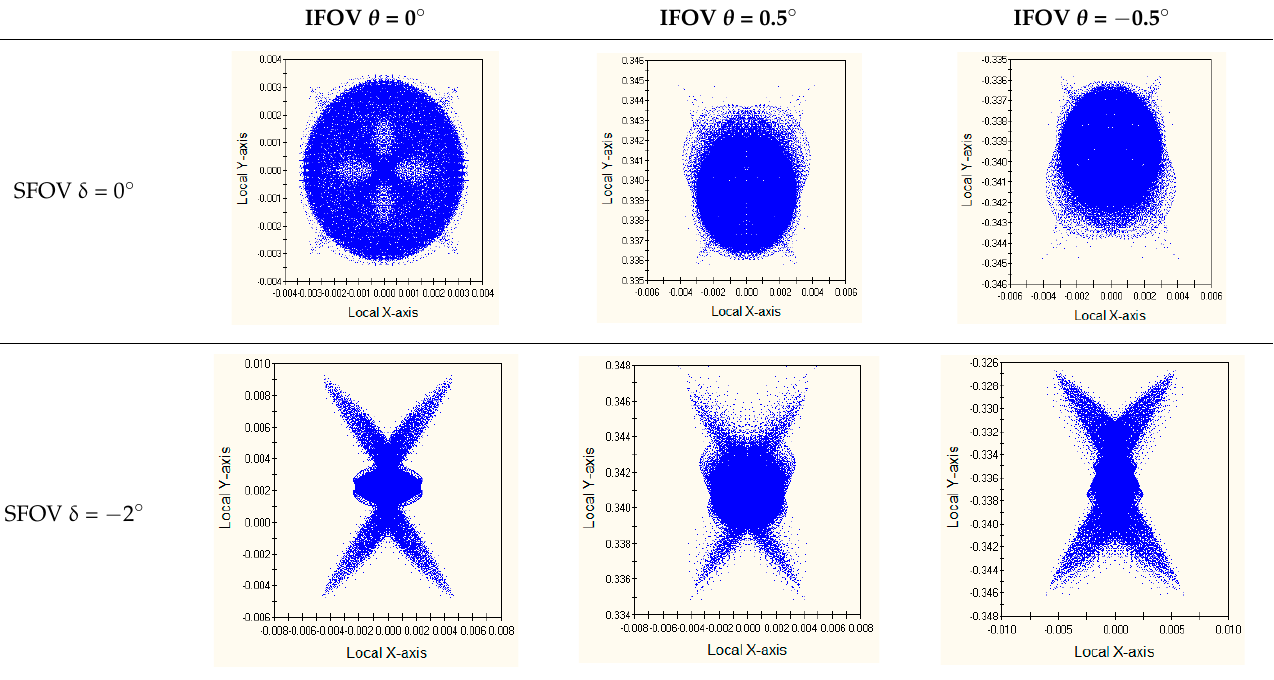
Table 5. Imaging for different SFOV and IFOV values when the wavelength is 4.0 μ m.